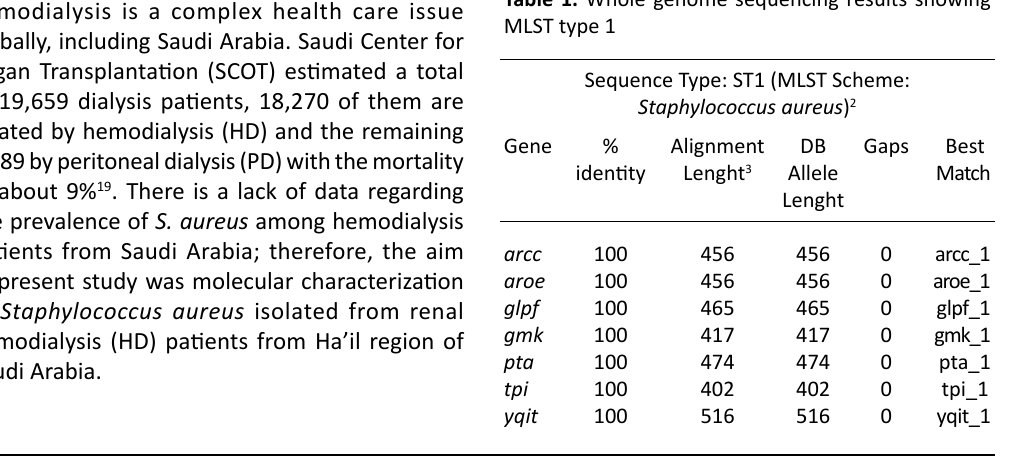
Table 1. Whole genome sequencing results